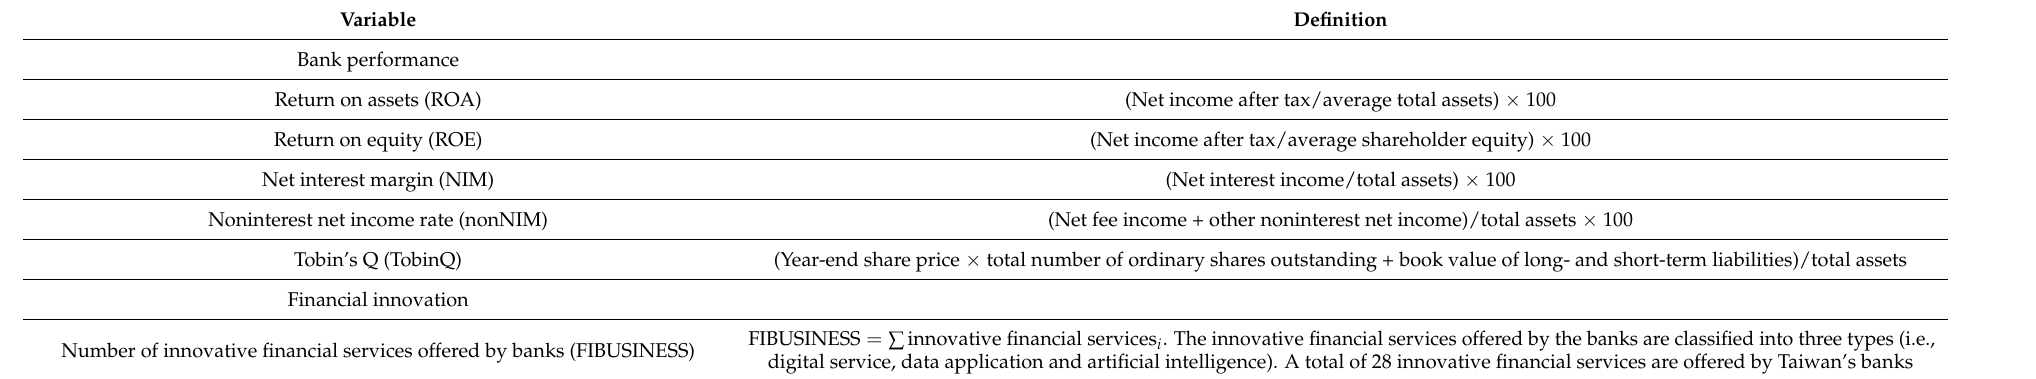
Table 1. Definition of